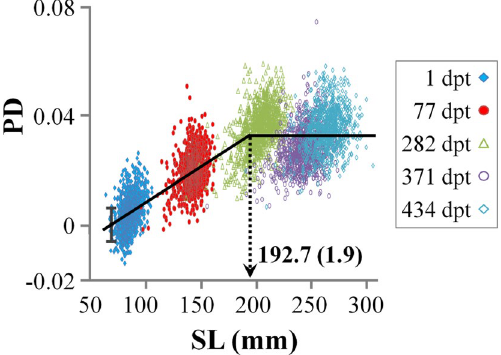
Figure 4. Relationship of the Procrustes distances (PD) to standard length (SL) throughout the on-growing period. Error bars (SD) correspond to the mean Procrustes distance of the 30 juveniles with the smallest SL, which composed the reference for the calculation of